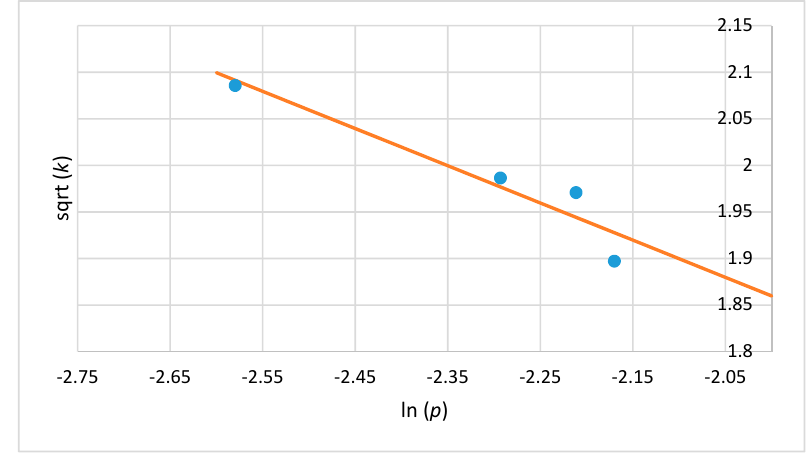
Figure 2. Linear relationship between ln ( p ) and sqrt ( k ) for B. cereus on the juniper berry matrix, where p and k are the scale and shape parameters of the Weibull model (Equation (4)). Int. J. Environ. Res. Public Health 2017 , 14 , 1196